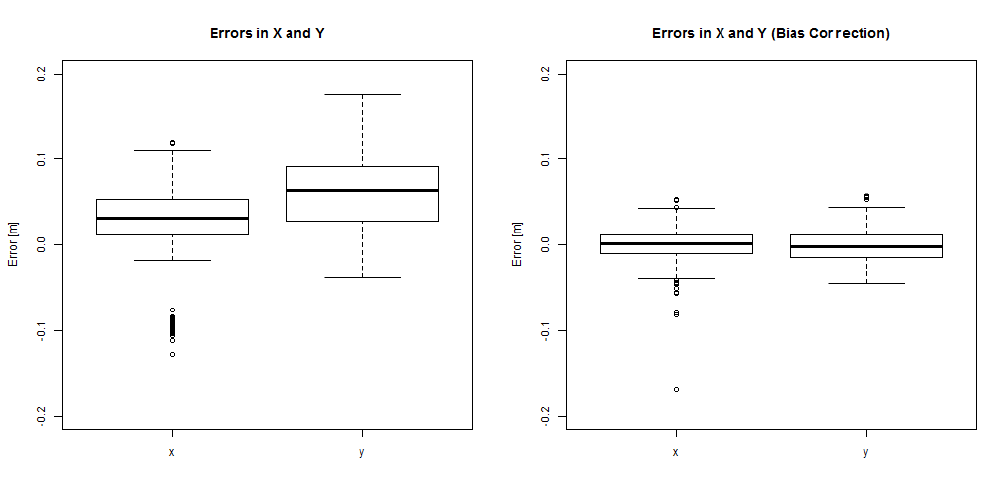
Figure 12. Boxplots of deviations in X (horizontally) and Y (vertically). Left : Original data. Right : Data after correction of session-wise